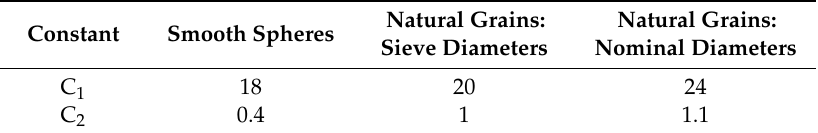
Table 3. Smoothness and shape drag coefficient values for Equation (2). Constant Smooth Spheres